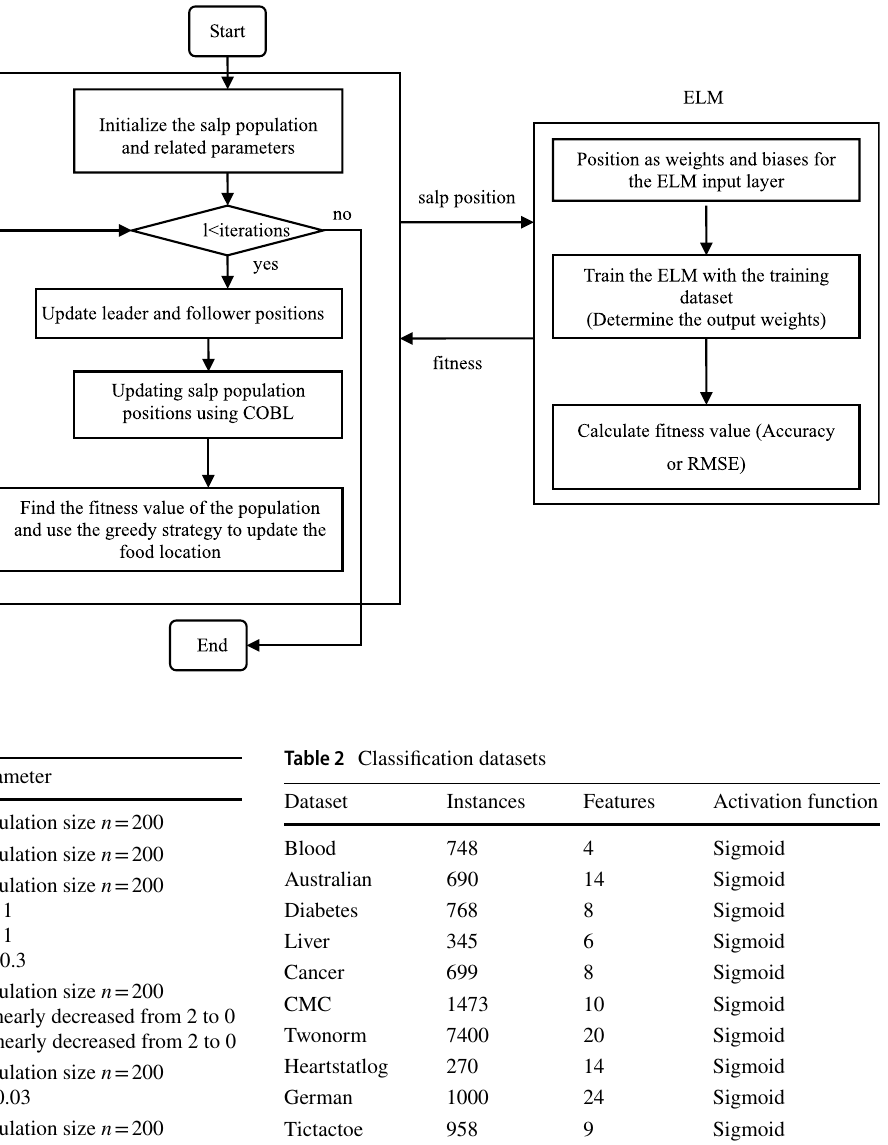
Fig. 2 The flow chart of NSSA- ELM